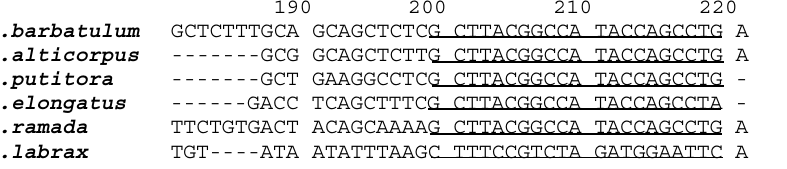
Figure 3. Aligned 5S rDNA sequences subcloned from Onychostoma barbatulum and O. alticorpus and four reference sequences obtained from NCBI GenBank (with accession numbers): Tor putitora (EU621853), Leporinus elongatus (AF284729), Liza ramada (AM706452), and Dicentrarchus labrax (HM014367). The first 99 bp and the last 21 bp, corresponding to the 5S rDNA transcribed sequences, are underlined.